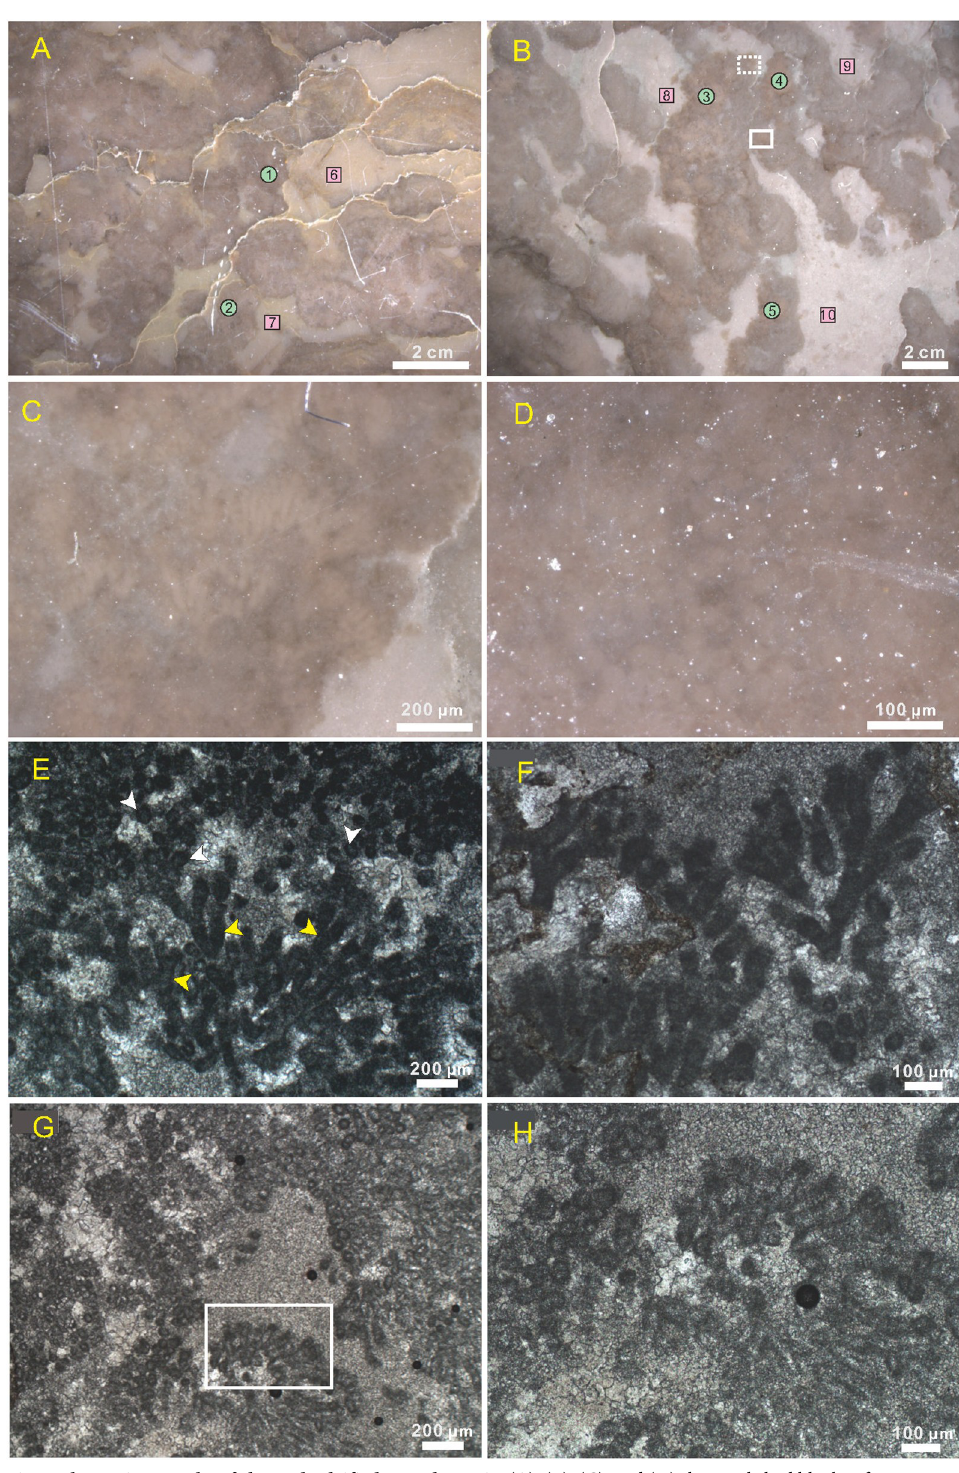
Fig 3. Photomicrographs of clot and calcified cyanobacteria. (A), (B), (C), and (D) show polished blocks of thrombolites viewed under reflected light, while (E), (F), (G) and (H) show calcified cyanobacteria viewed under transmitted light. (A) Clear boundary between a black clot and grey infilling. The positions of the figure represent geochemical sampling points that are listed in Table 1. (B) Brown patches in the dendritic clot suggest non- homogeneous internal components. (C) Enlargement of the rectangular (dashed line) area in (B) showing